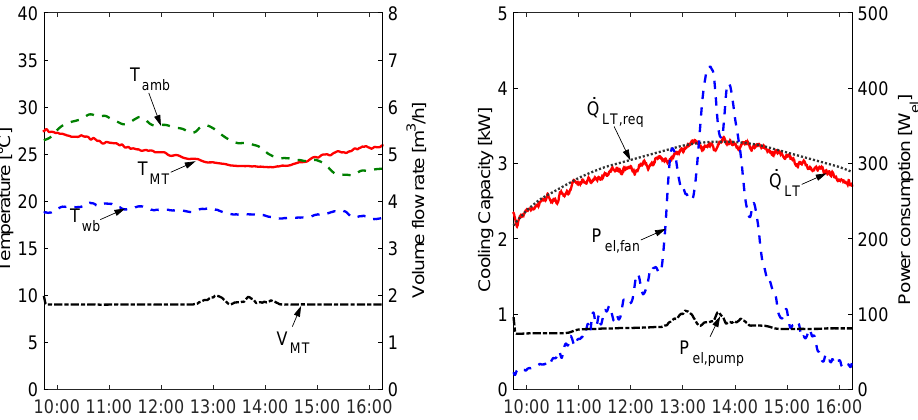
Figure C1. Another measurement sample day with matched cooling load (mode